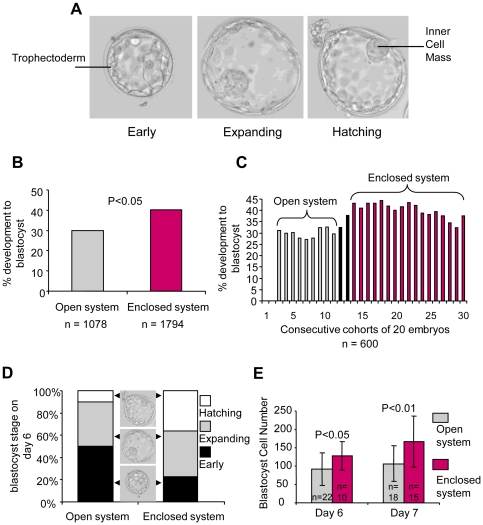
Comparison of development to the blastocyst stage between the enclosed workstations and conventional open-fronted cabinets.(A) Images show examples of early, expanded and hatched human blastocysts indicating the trophectoderm and the ICM. (B) Development of embryos to the blastocyst stage was compared between the open and enclosed systems. A significantly higher proportion of embryos developed to the blastocyst stage in the enclosed system (P<0.05). (C) Three point moving average of development to the blastocyst stage in consecutive cohorts of twenty embryos. The increase in the proportion of embryos developing to the blastocyst stage coincides with the switch from the open to the enclosed workstations. The two dark bars represent the intermediate period when the cohorts of 20 consisted of embryos cultured in the open and enclosed systems. (D) The proportions of blastocysts graded as early (black), expanded (grey) and hatched (white) on day 6. A significantly higher proportion of blastocysts had undergone hatching by day 6 after culture in the enclosed system compared to the open system. There was a corresponding reduction in the proportion of early blastocysts in the enclosed system (P<0.05). (E) Nuclear counts were performed to compare the total number of cells contained in blastocysts cultured to day 6 or 7 in the open system or enclosed system. The cell count of embryos cultured in the enclosed system was significantly higher on day 6 (128.3±38.6 vs 92.1±43.7; P<0.05) and day 7 (167.7±69.7 vs 106.7±48.8; P<0.01) compared with those cultured in the open system. See Figure S1A–C for an example of nuclear staining in a blastocyst and comparison of nuclear counts between different operators and imaging systems.